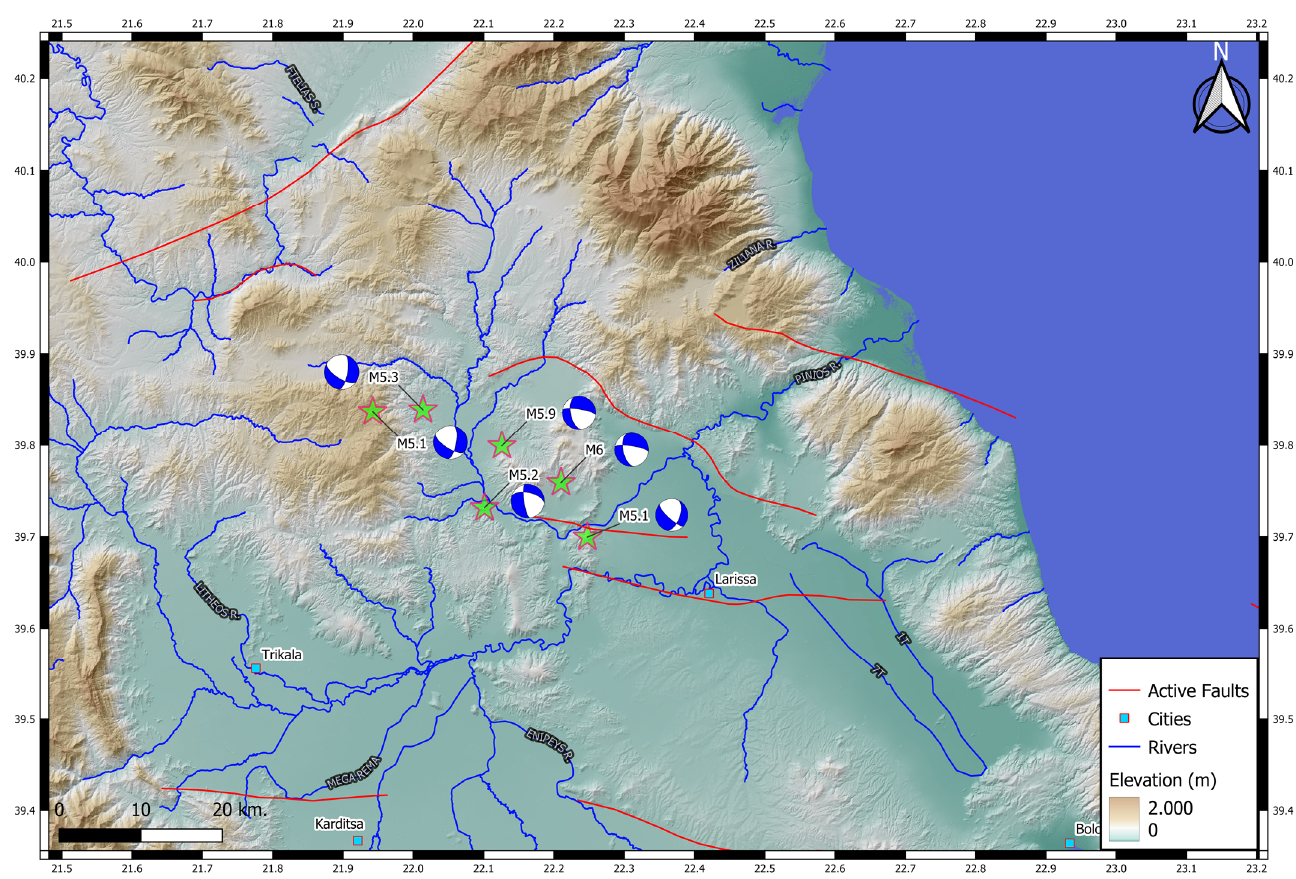
Figure 15. A seismotectonic map of the study area. On the map, the epicenters appear for the study area's more significant events, corresponding focal mechanisms, and significant faults.